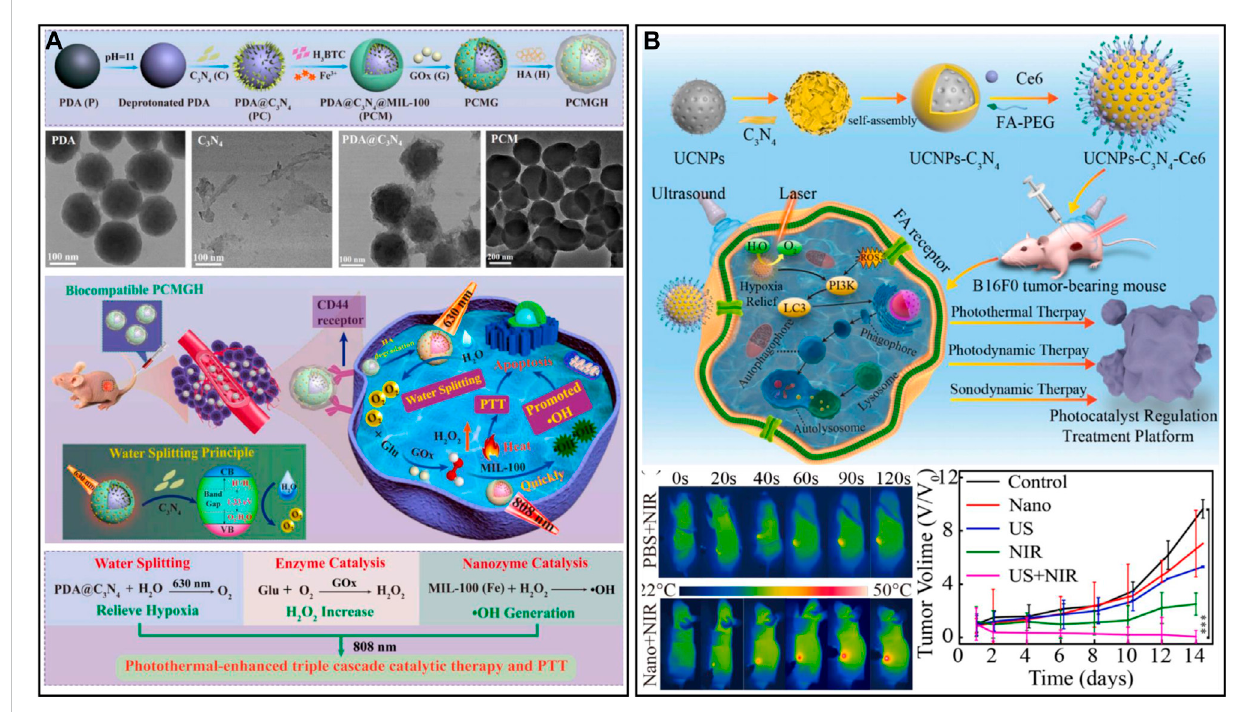
FIGURE 8 (A) Cascade catalyst PCMGH for tumor hypoxia therapy. Reproduced from ref. (Hou et al., 2022) with permission from Elsevier, copyright 2021. (B) UCNPs-C 3 N 4 -Ce6 for responsive tumor therapy. Reproduced from ref. (Wei et al., 2021) with permission from Elsevier, copyright